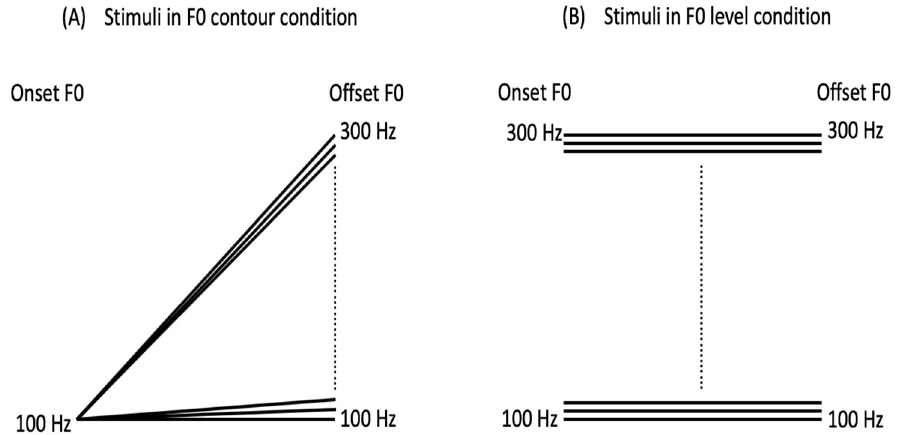
Figure 1. Schematic representation of linear F0 contours in F0 contour ( A ) and F0 level ( B ) conditions.